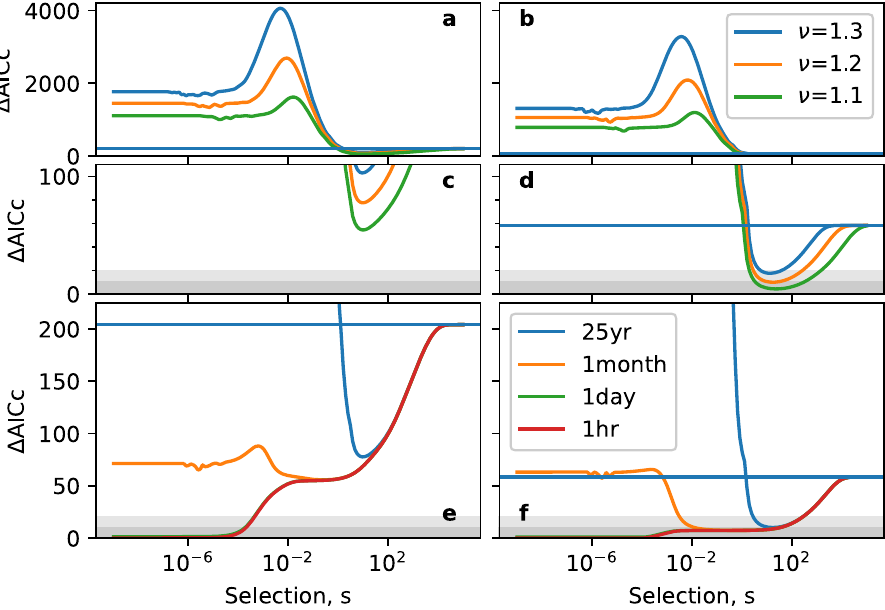
Fig 7. Δ AIC for models on heterogeneous social networks for the definite (panels a, c and e) and indefinite (b, d and c f) articles as a function of selection strength s . Panels a–d show the effect of different degree exponents ν on the child- based model: panel c and d zoom in on Δ AIC c � 100, showing that plausibility is obtained only for the indefinite article over a limited range of s and ν . Panels e and f show the effect of memory lifetime at fixed ν = 1.2 and � = 1. The horizontal line has the same meaning as in Fig 6. The dark and light shaded regions correspond to Δ AIC c < 10 and Δ AIC c < 20, respectively, which allows one to see the sensitivity to different evidence